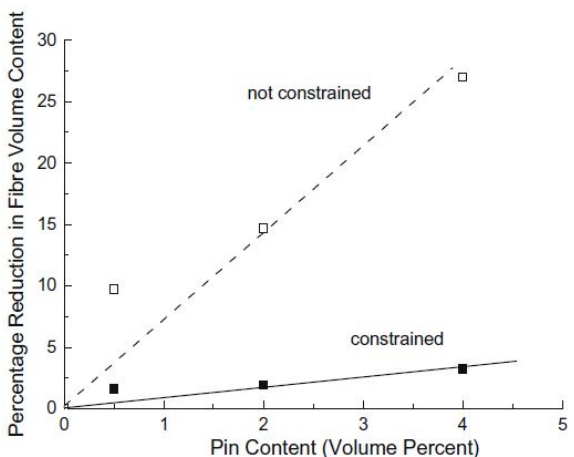
F igure 7. Effect of z-Pin content on the percentage reduction in fiber volume content of a unidirectional carbon-epoxy. The preform was either constrained or not constrained during the pinning process [15].